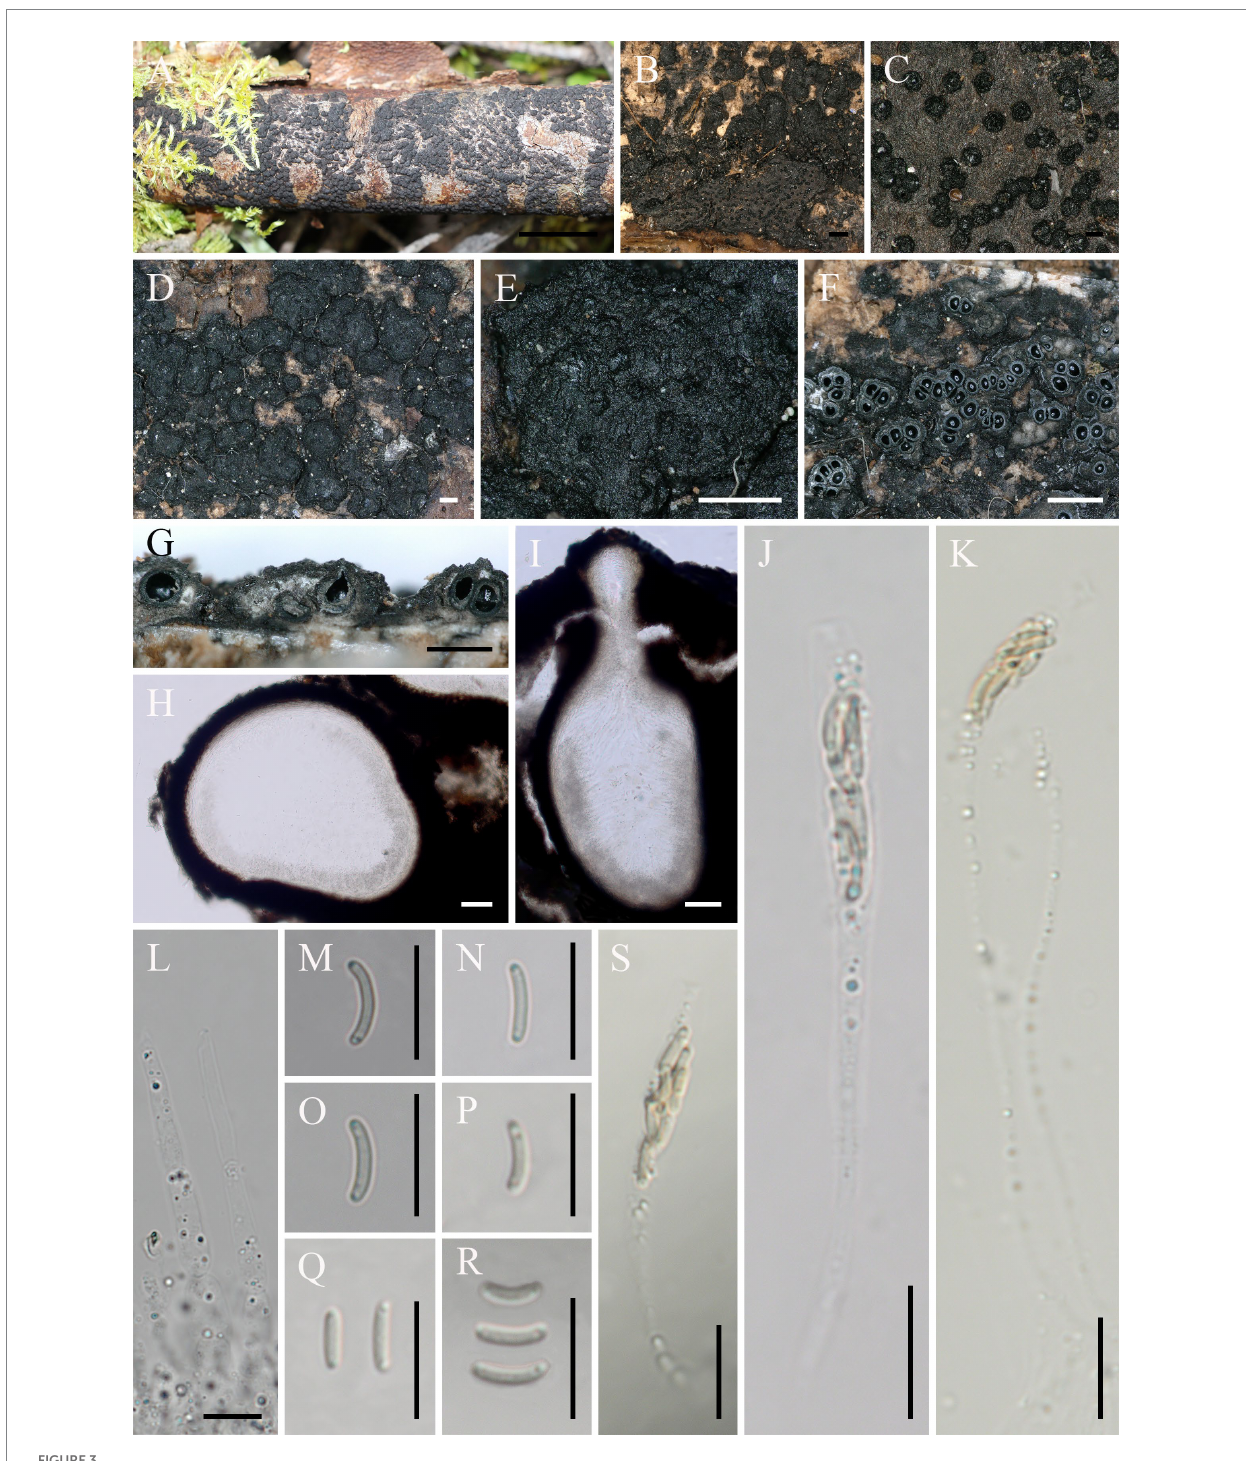
FIGURE 3 Diatrype linzhiensis (FCATAS 4304, Holotype). (A–E) Stromata on substrate. (F) Cross section of a stroma. (G,I) Vertical section through stroma showing ostiole and perithecia. (H) Peridium. (L) Paraphyses. (J,K,S) Asci. (M–R) Ascospores. Scale bars: (A) = 15 mm; (B) = 500 μ m; (C) = 100 μ m; (D,E,G) = 500 μ m; (F) = 1 mm; (H,I) = 50 μ m; (J–S) = 10 μ